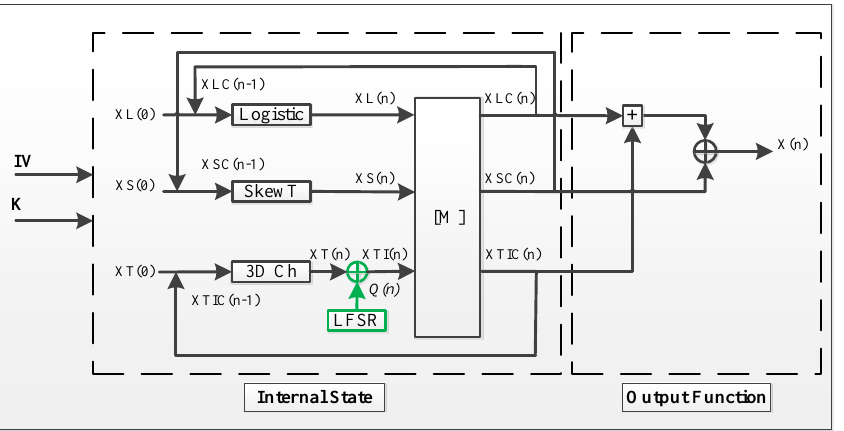
Figure 7. LST-PRNG design architecture